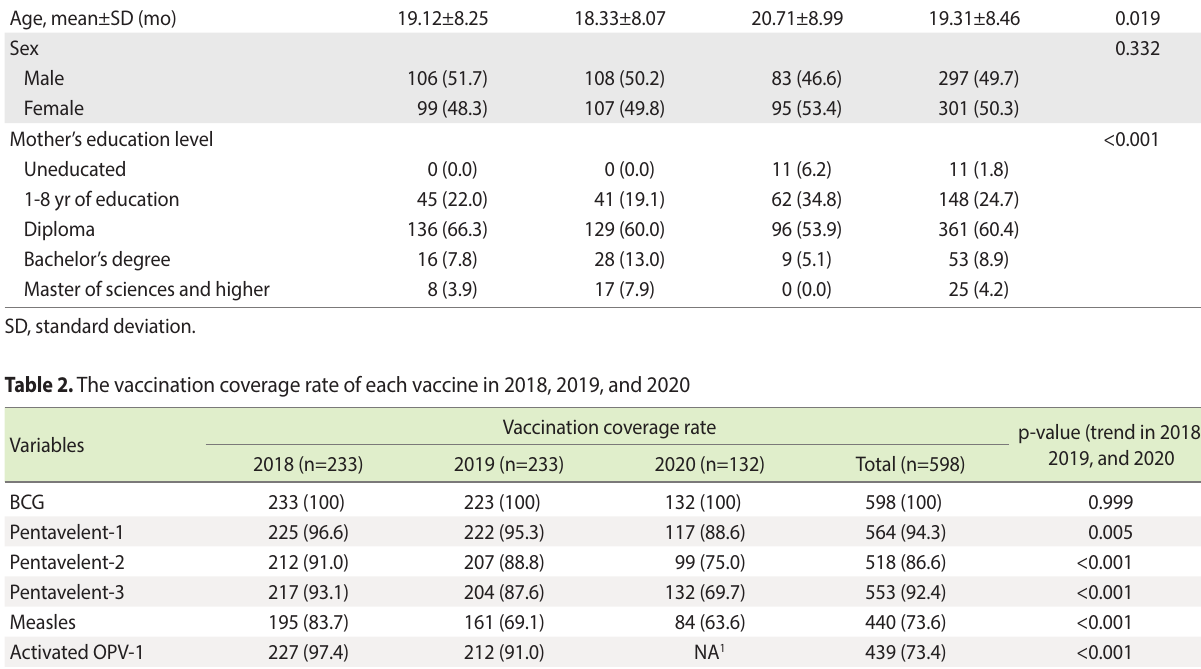
Table 1. Baseline characteristics of the participants and families in 3 sub-districts Characteristics